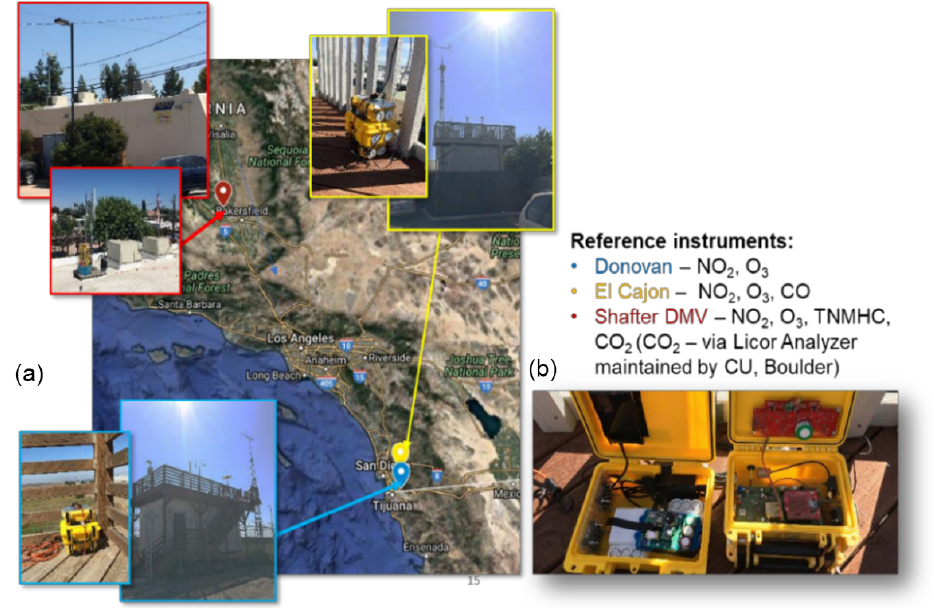
Figure 3. (a) Map and images of deployment locations. The Shafter DMV (red) was located 250mi (402km) away from Donovan (blue) and El Cajon (yellow), which were located in San Diego, CA. (b) Deployment containers’ configuration for the extended deployment. Each container has active ventilation to keep the internal conditions equivalent to the ambient